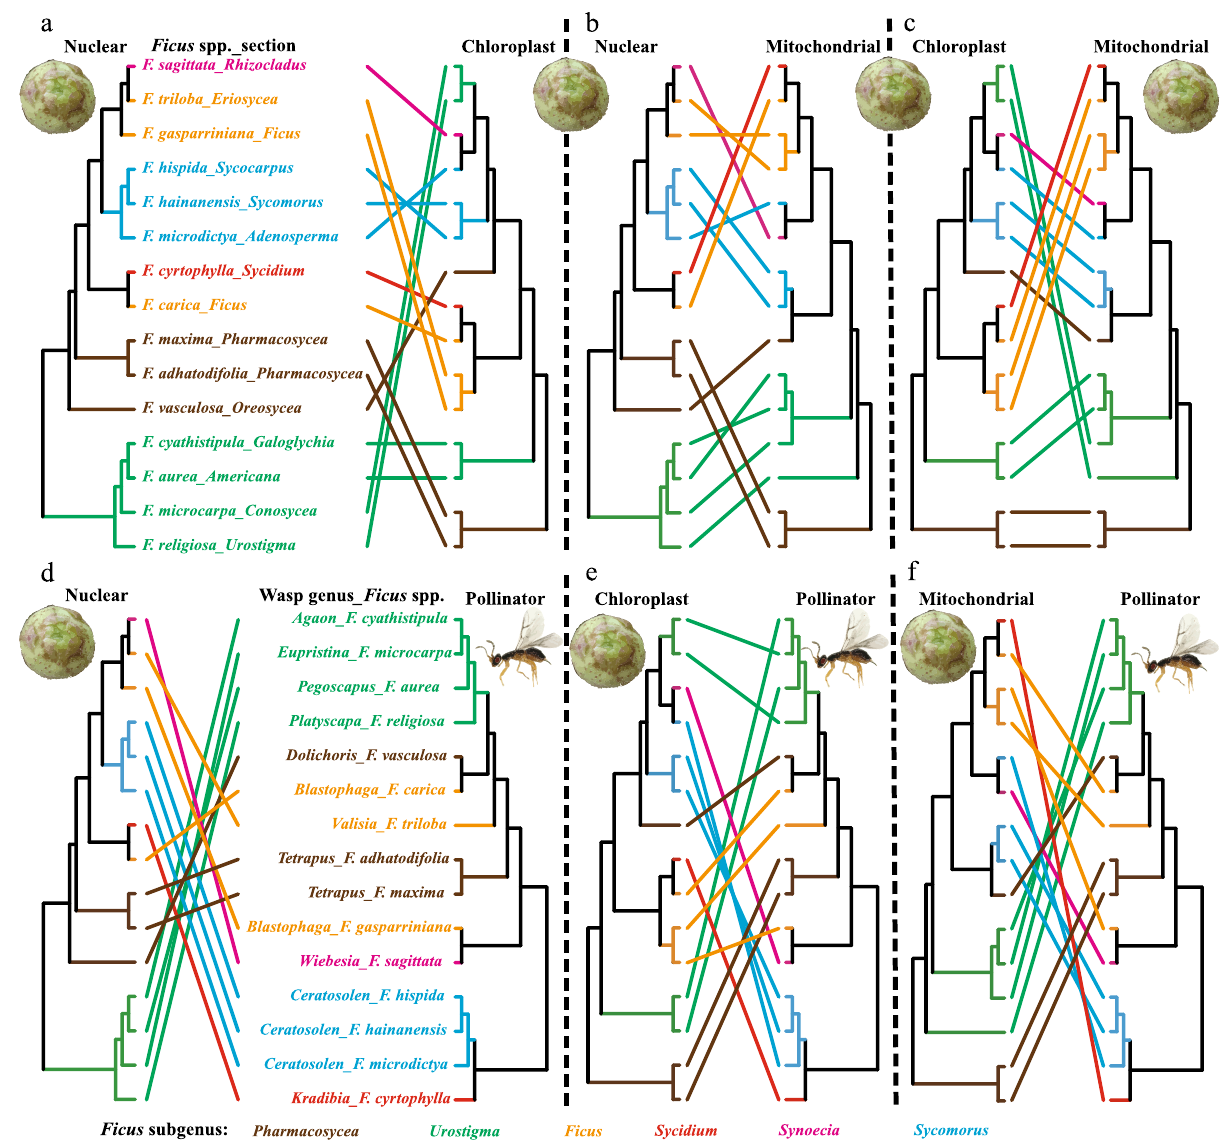
Fig. 3 Phylogenetic incongrugence among fi g genomic compartments and pollinator. Cophylogenetic comparison of each pair of phylogenies of three genomic compartments ( a – c ) and of the pollinators associated with the 15 fi g species studied ( d – f ). Ficus and pollinator phylogenies used were indicated with symbol of fi gs and wasp separately. Tip-name colors indicate subgeneric classi fi cation. The pollinator phylogeny extracted from Cruaud et al. 20 was used here. Extensive phylogenetic incongruence is shown for each pair of phylogenies. Refer to Supplementary Figs. 1, 4, and 5a and Appendices 1 and 5 for details on the phylogenies used